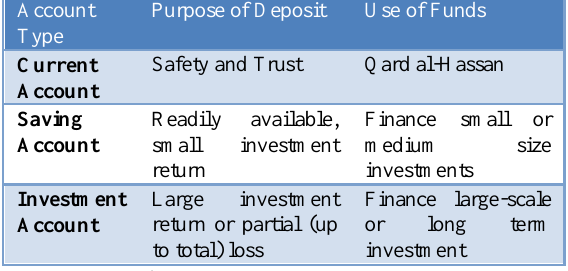
Table-2: Islamic Banking Accounts at a Retail